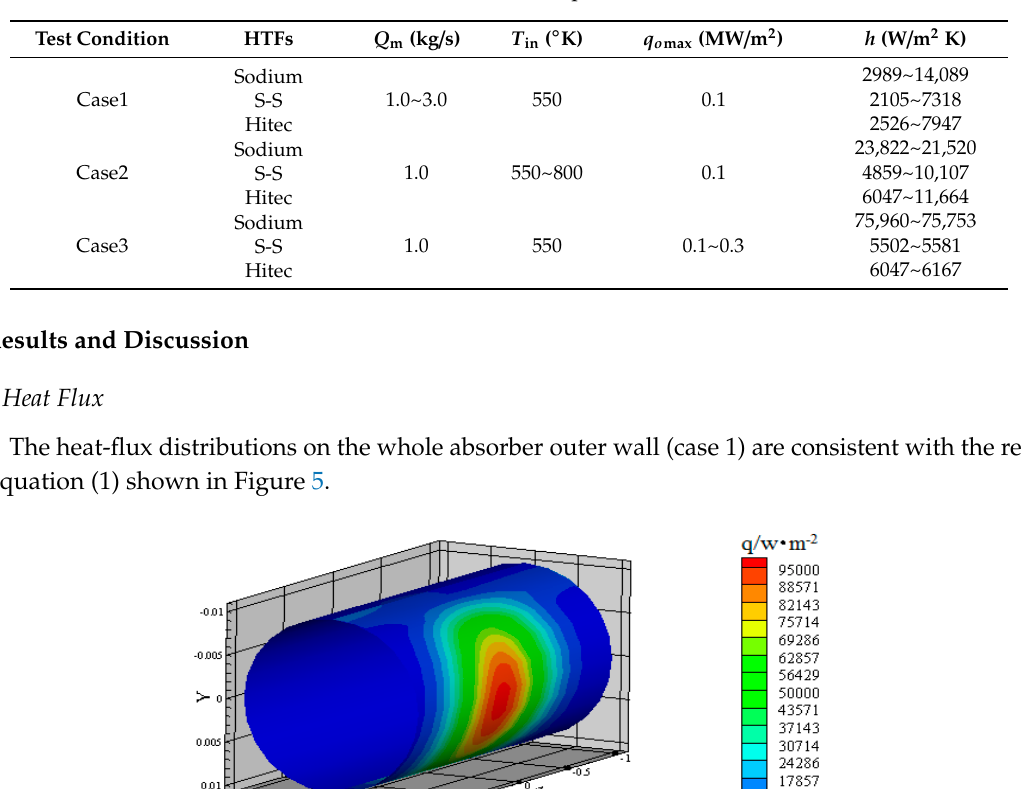
Table 2. The calculation parameters.